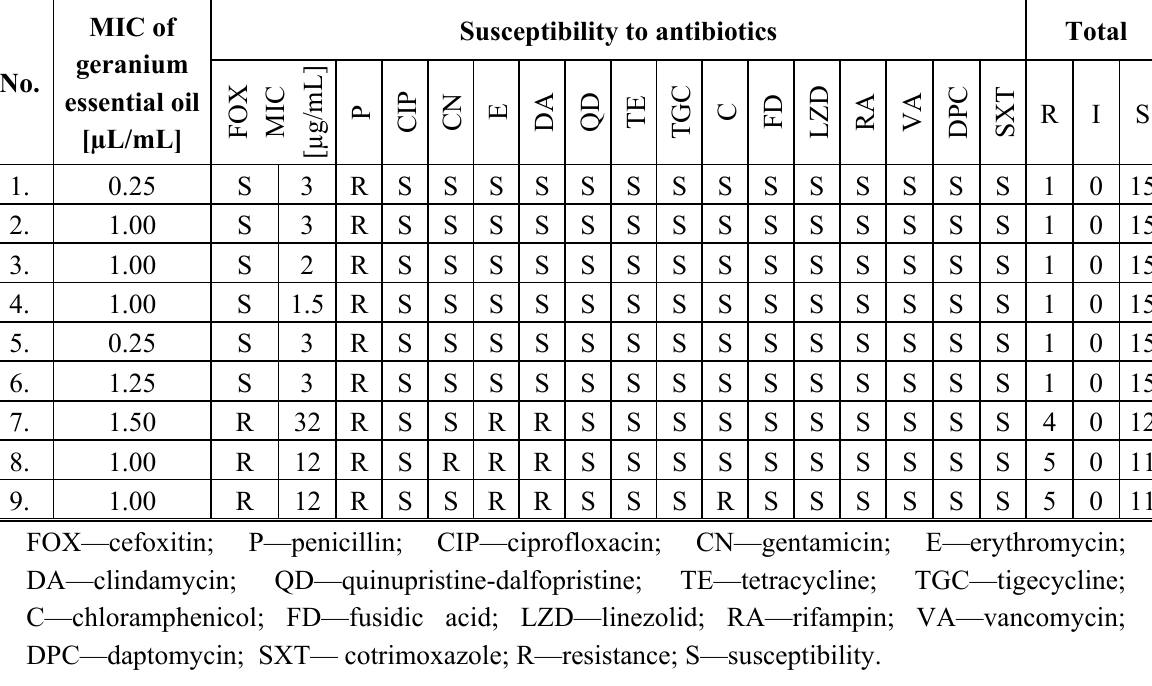
Table 3. Characteristics of S. aureus strains isolated from skin lesions.